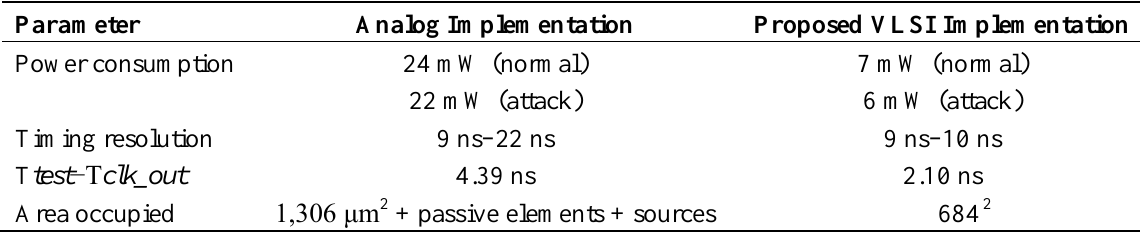
Table 3. Comparison results between both analog and proposed VLSI